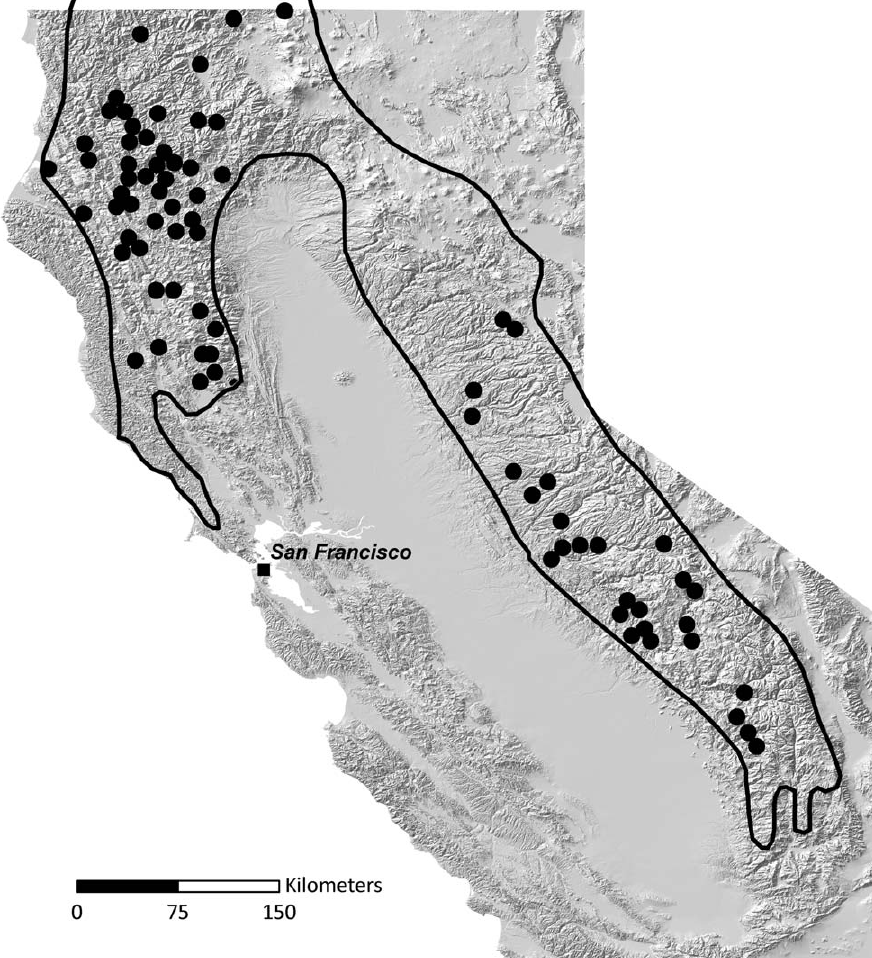
Figure 1. Historical range map for fisher in California. Fisher locations used by Grinnell et al. [26] to document the distribution of fisher in California. Locations are based primarily on reports of trappers and collecting expeditions from 1919–1924. Grinnell wrote that ‘‘spots [black dots] indicate, almost all of them with certainty, the locality of capture; probably some indicate the residence of post office or trapper’’. The outlined area is the Grinnell et al. [26] assessment of the range of fisher in California from , 1850–1925.